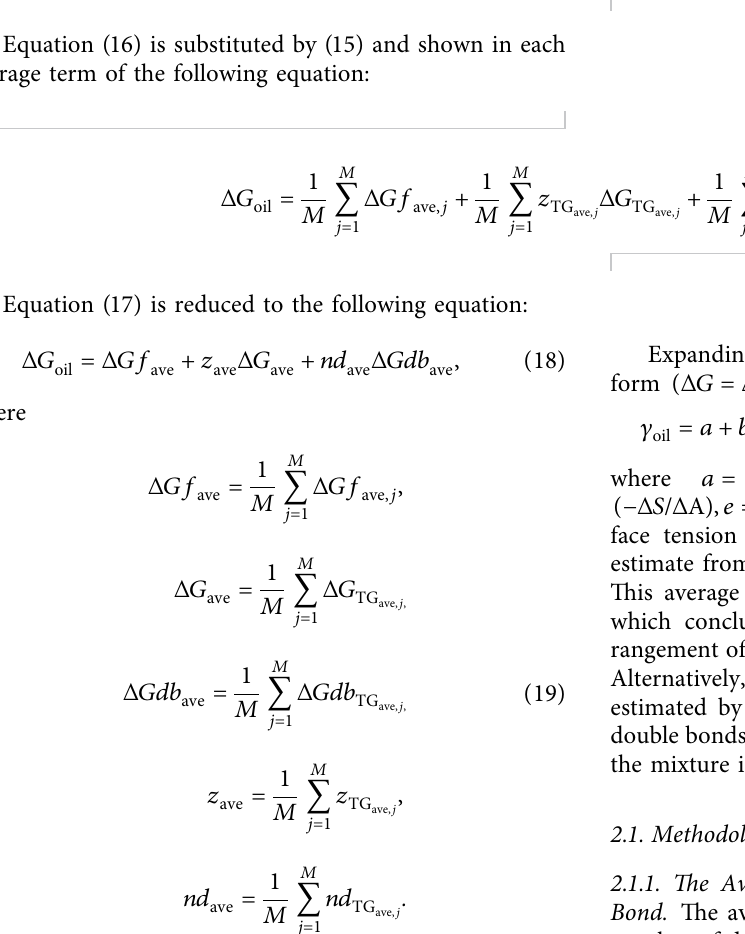
Figure 1: Molecular structure of